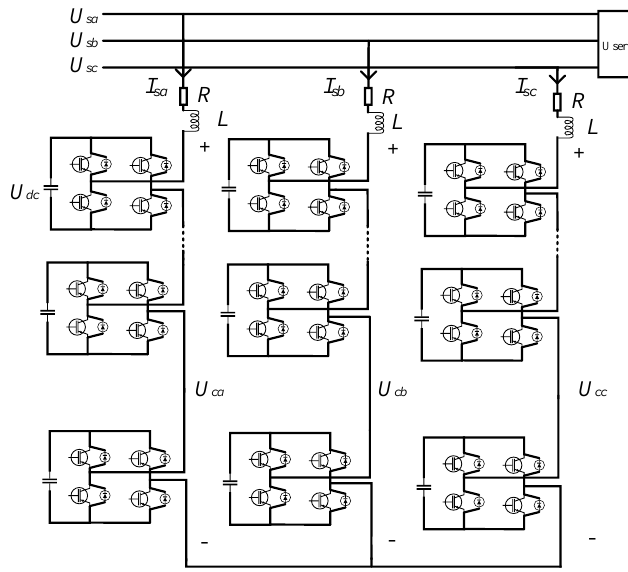
Figure 1. Main circuit topology.